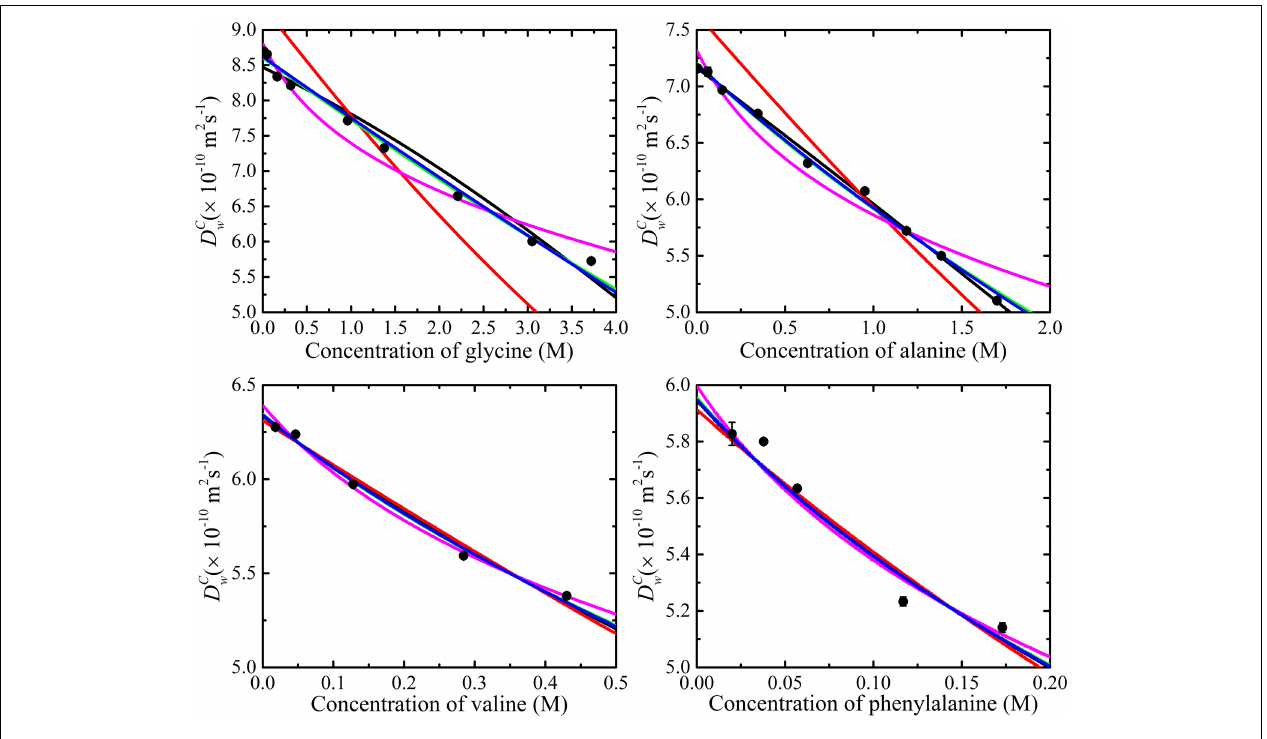
( ) best fit to experimental data. Also shown are Jönsson et al. ( ) and T and O’s long interactions model ( ). The error bars for the measurements are also included; however, the errors are much smaller than